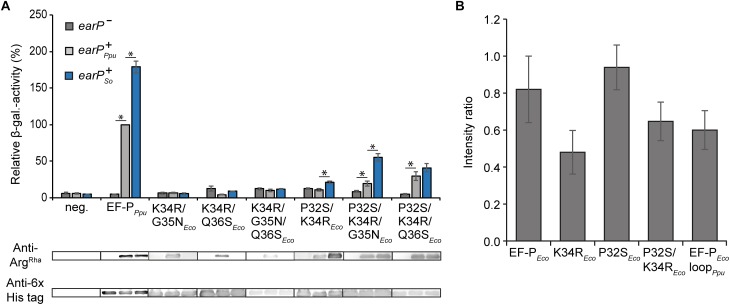
In vivo and in vitro characterization of EF-P hybrids (A) Top: In vivo rhamnosylation and functionality analysis of EF-P hybrids co-expressed with EarP from P. putida or S. oneidensis. Measurements were performed in the E. coli reporter strain (MG-CR-efp-KanS). E. coliΔefp cells were complemented either with plasmid encoded His6-tagged EF-PEco/Ppu variants solely (earP-, dark gray bars) or in combination with either EarP from P. putida (earP+Ppu, light gray bars) or EarP from S. oneidensis (earP+So, blue bars). β-galactosidase activities are given in relative MU with the wild-type EF-PPpu in earP+Ppu cells set to 100%. Asterisks indicate significant (P < 0.05) differences in the ribosome rescue activity of a given EF-PEco variant in the presence of EarPPpu or EarPSo compared to the same variant in the absence of EarP. Bottom: In vivo rhamnosylation levels were detected and visualized using Anti-ArgRha. Production of EF-PPpu and EF-PEco variants was detected and visualized using Anti-6×His®. (B) NMR-single titration experiment: Average change in the intensity ratio of EF-PEco and its variants upon titration with twofold EarPPpu. Error bars represent standard deviation of the intensity ratios over all signals within each titration.